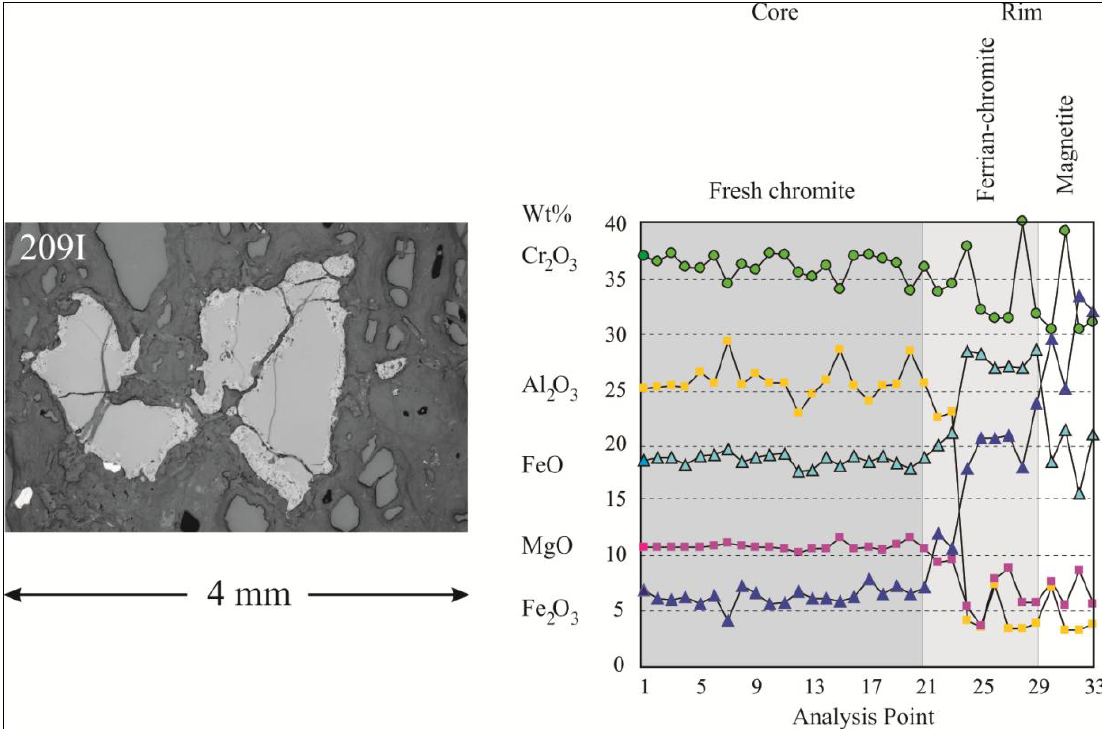
Figure 5. Chemical variation across the chromitite core (fresh chromite) to rim (ferrian chromite) and boundary (chromian magnetite) zoning in accessory chromite from the serpentinized dunite host of the CHR-1